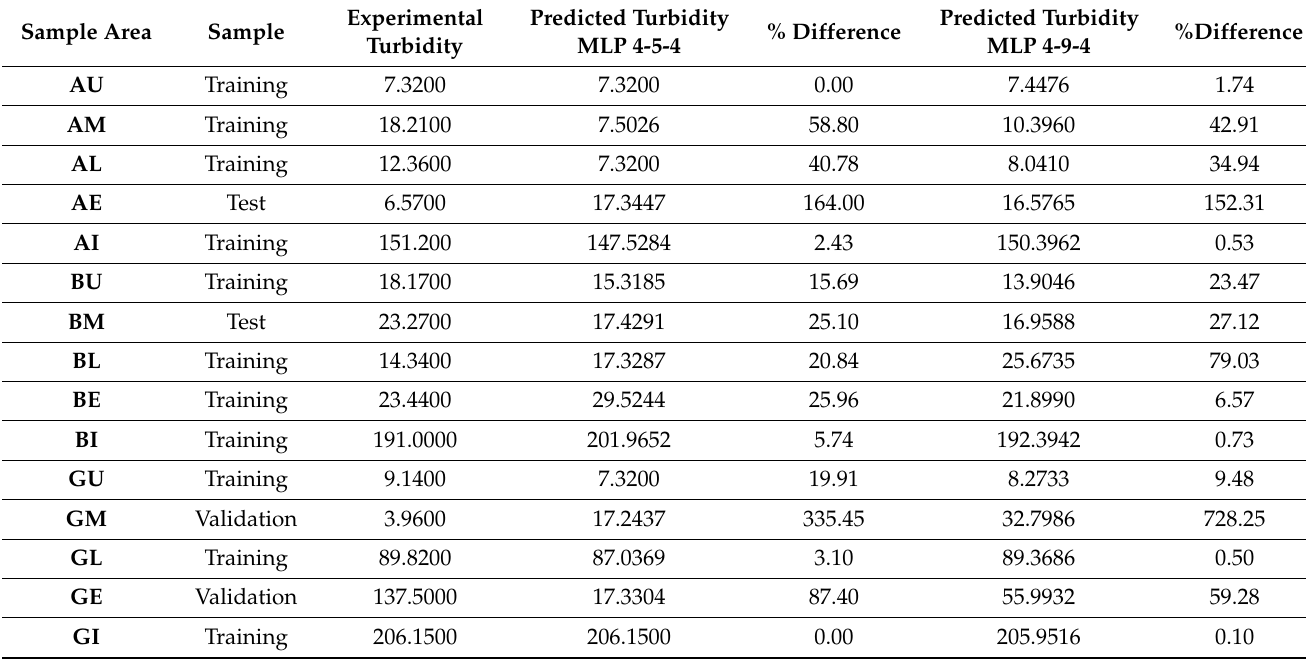
Table 6. Experimental and predicted values for turbidity generated by MLP 4-5-4 and MLP 4-9-4 networks. Sample: Training, Test, Validation.